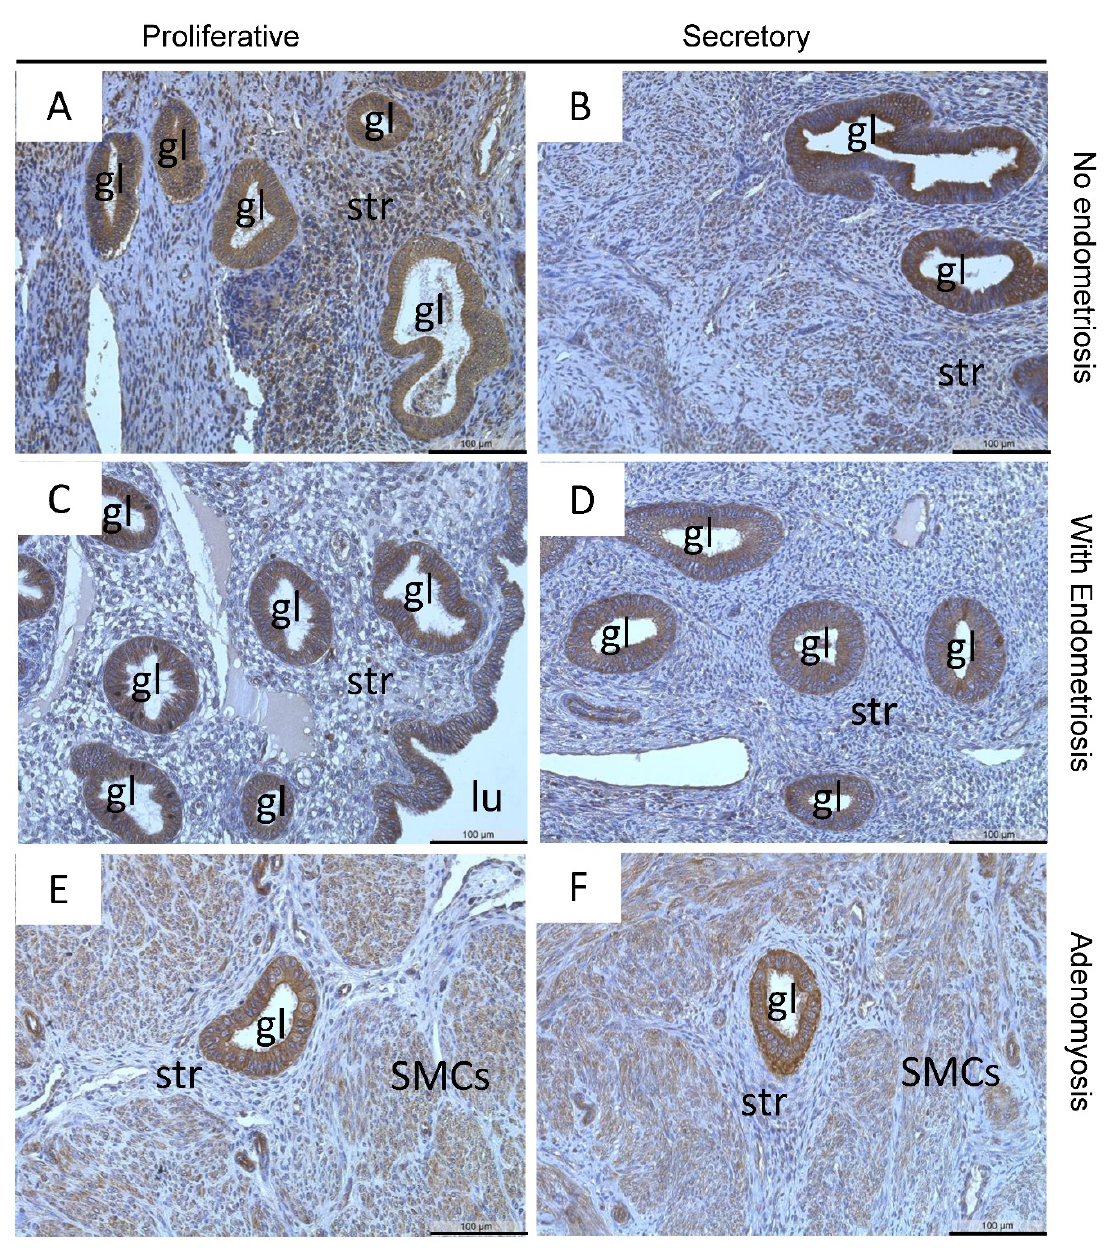
Figure 4. Localization of MT3-MMP was found in the glandular epithelial cells and stromal cells in proliferative ( A ) and secretory ( B ) endometrium of patients without endometriosis, in proliferative ( C ) and secretory ( D ) endometrium of patients with endometriosis, as well as in proliferative and secretory adenomyosis ( E , F ), respectively. Counterstaining was performed with hematoxylin. Magnification ( A – F ) 20×, scale bars 100 μm; gl, gland; str, stroma; lu, lumen; SMCs, smooth muscle cells.